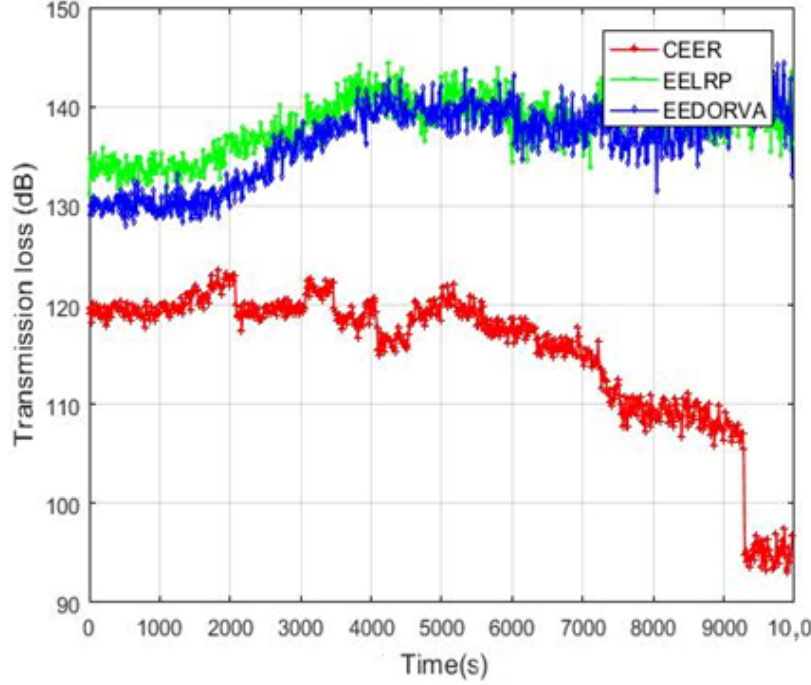
Figure 8. Transmission loss of proposed and EELRP and EEDORVA.